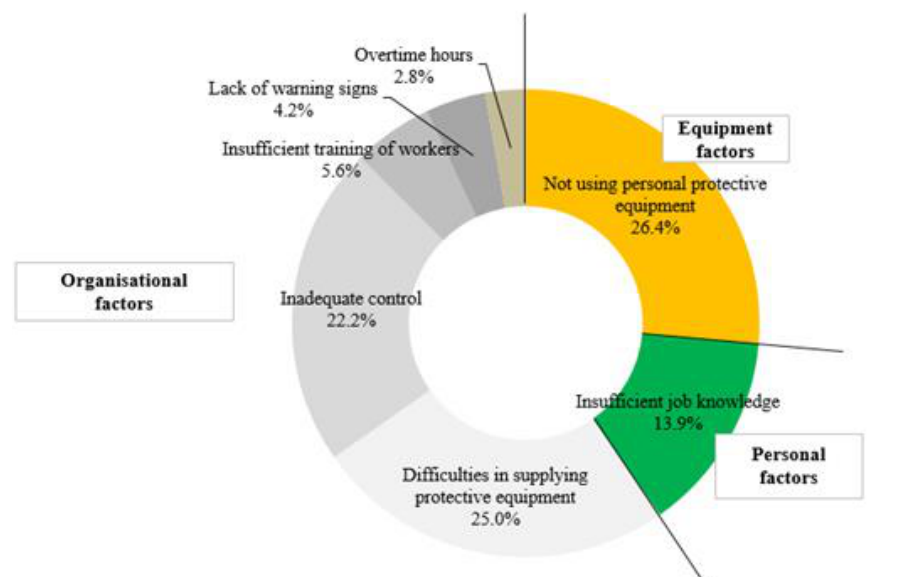
Figure 1. Risk factors influencing the H&S related NCs (% of all H&S related NCs) from FSC audit reports (2013–2018) in Romania.